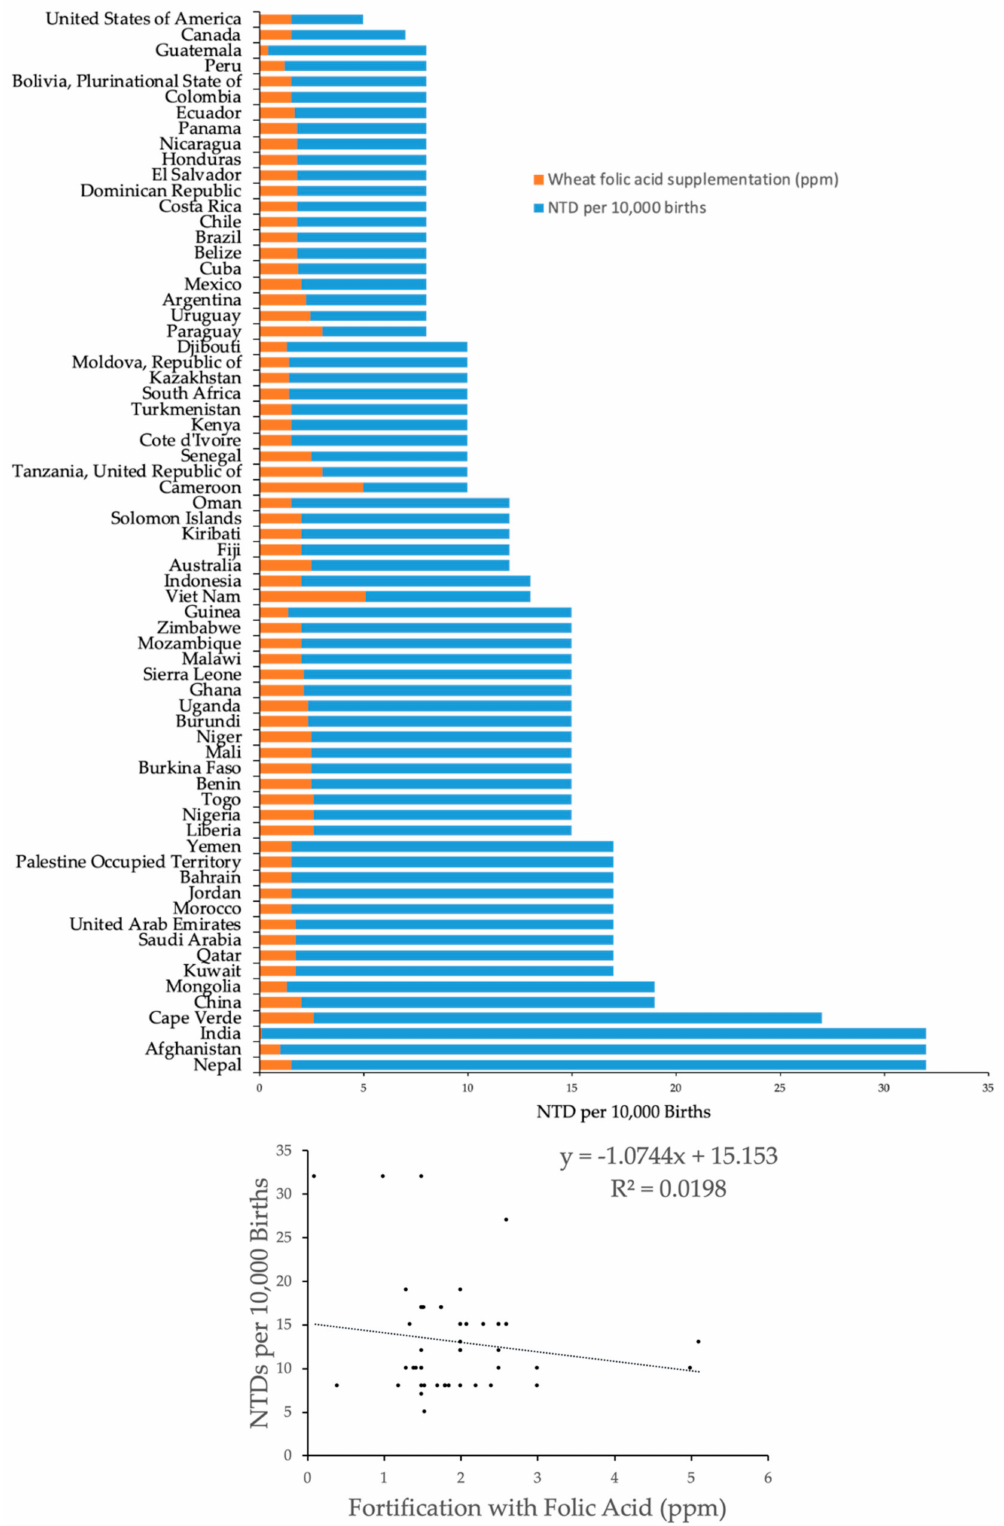
Figure 1. Prevalence of NTDs as a function of folic acid fortification levels in wheat. The number of NTDs per 10,000 births was plotted (blue bars) versus country ( n = 68). Folic acid fortification levels of wheat in ppm (orange bars) were superimposed on NTD prevalence. Linear regression analysis indicates a regression coe ffi cient (a) of −